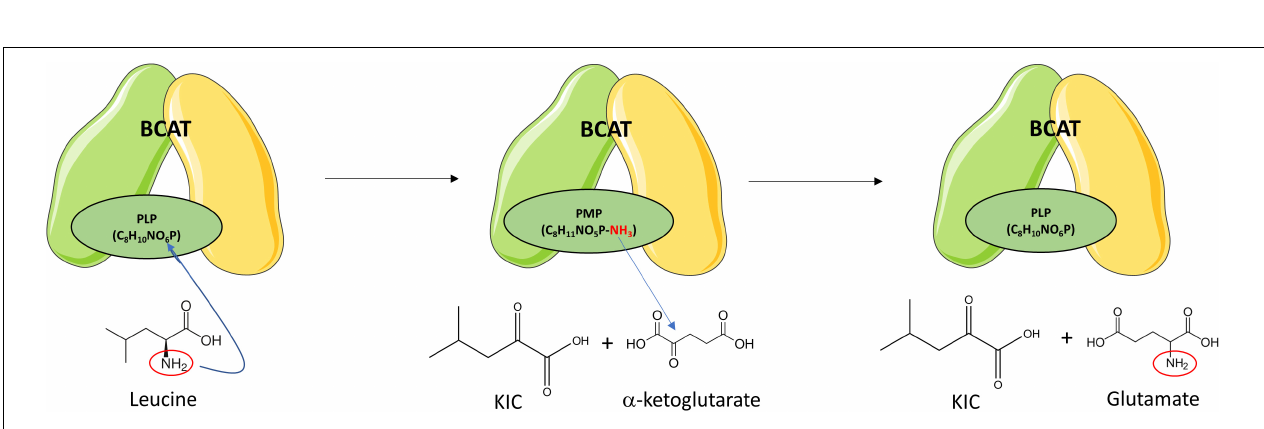
Frontiers in Physiology |